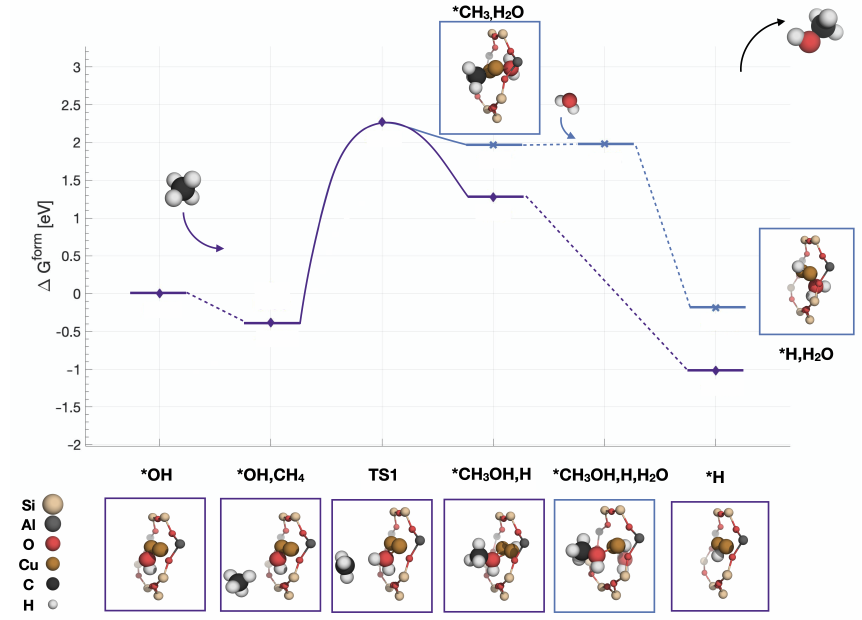
Figure 3. Reaction path over Z 2 [Cu 2 OH]. Purple diamonds mark the mechanism under dry con- ditions, blue cross the addition of one H 2 O and grey triangles when two H 2 O are included in the reaction. Gibbs free energies are in eV and relative to that of Z 2 [Cu 2 OH] with CH 4 in the gas phase. Reaction conditions are set to T = 448 K, p CH to atmospheric